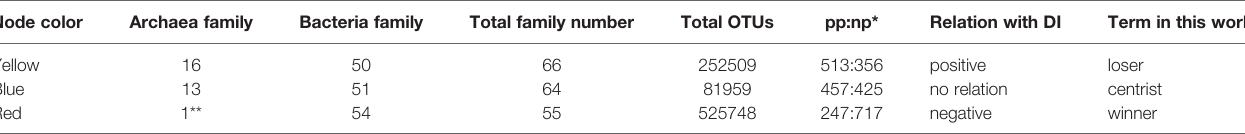
TABLE 3 | The classi fi cation of microorganisms in the network analysis as grouped by relation with DI on family level. Node color Archaea family